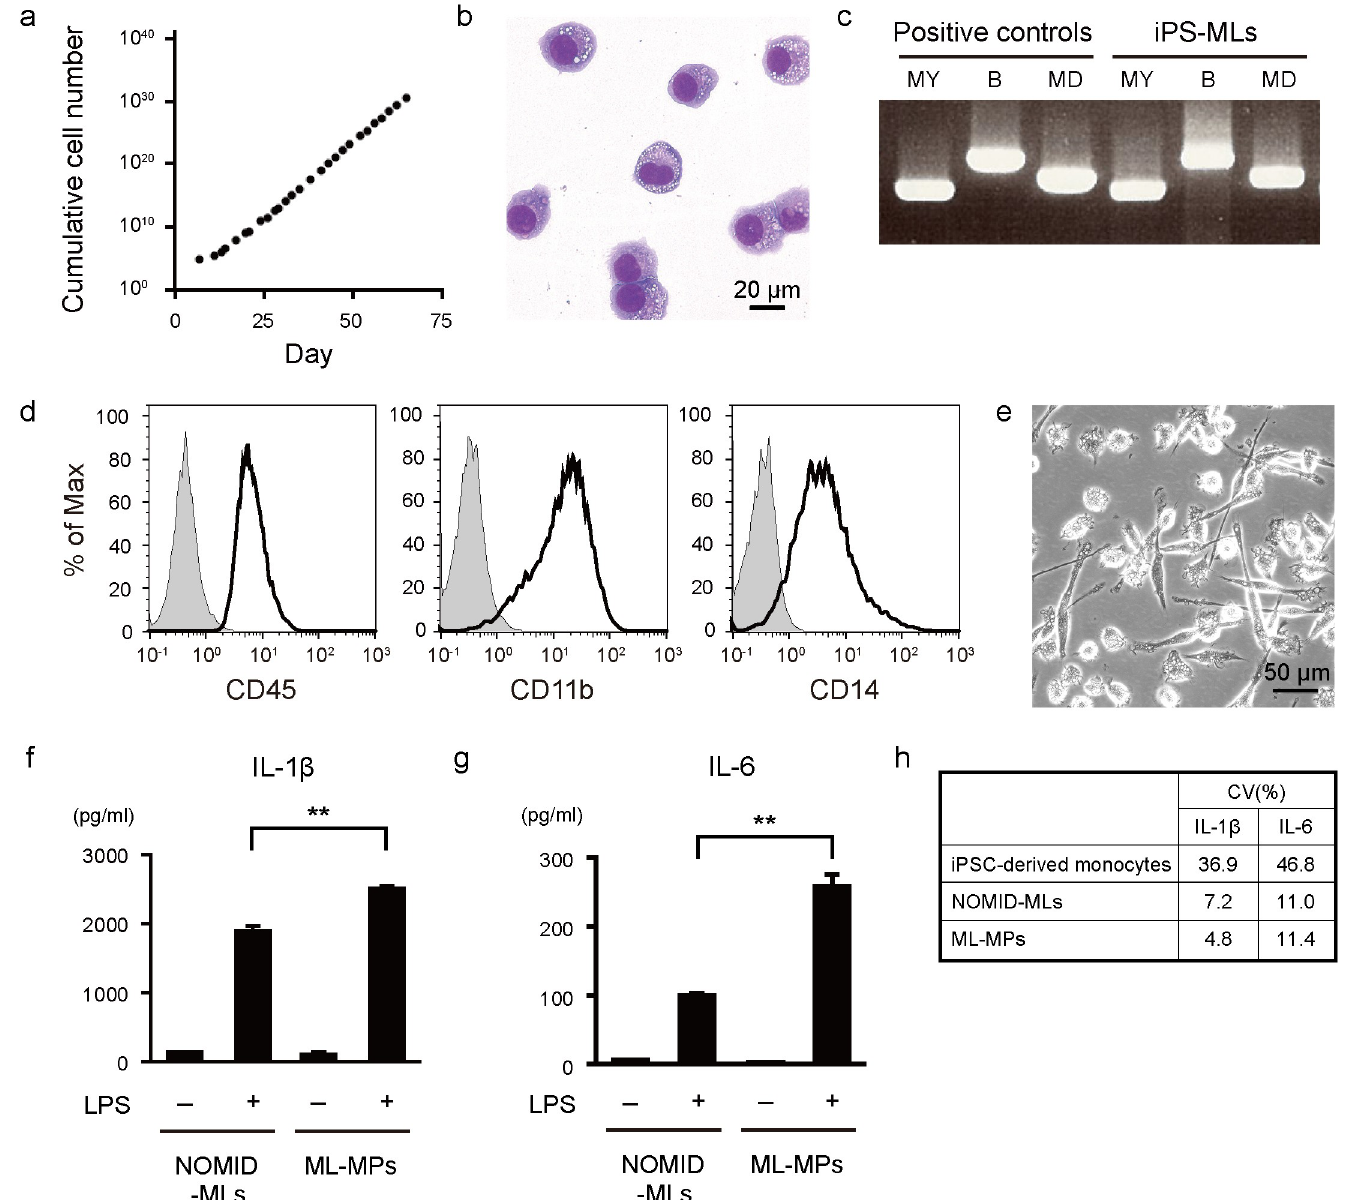
Fig 2. Establishment of iPS-MLs from monocytic cells. (a) Cumulative growth curve of iPS-MLs. The number of cells was counted and cumulated in every passage culture. The day of lentiviral transduction was regarded as day 0. (b) A representative May-Giemsa staining image of iPS-MLs. (c) A reverse transcription-PCR analysis of iPS-MLs. Transgene-specific primer pairs were used. MY: MYC , B: BMI1 , MD: MDM2 . As a positive control, lentiviral expression vectors were used. (d) A flow cytometric analysis of iPS-MLs. The staining profiles of specific antibodies (thick lines) and isotype-matched controls (gray areas) are shown. (e) A phase contrast image of ML-MPs. (f, g) IL-1 β (f) and IL-6 (g) secretion from NOMID-MLs and ML-MPs. Cells were stimulated with LPS (20 ng/ml) for 6 hours. The bars show the mean ± S.E.M. of four experiments. �� P < 0.01 (paired t -test). (h) The coefficient of variation (CV) of LPS-stimulated iPSC-derived monocytes (Fig 1C and 1D), NOMID-MLs and ML-MPs (f,